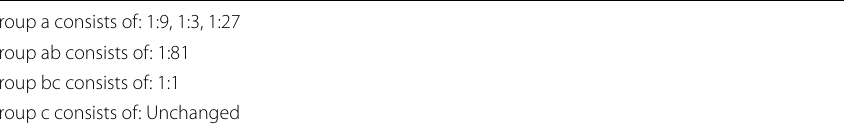
Table 12 HSD test groupings after ANOVA of AUC for the RUS